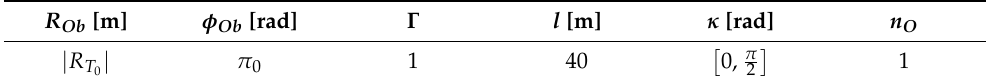
Table 3. Target geometry.